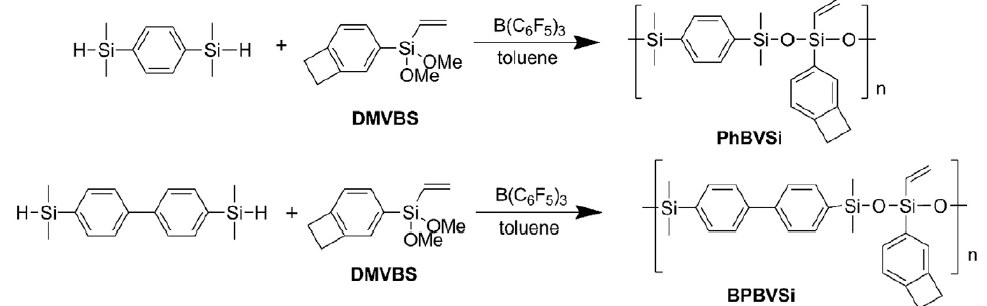
Figure 4. Synthesis of benzocyclobutene (BCB) oligomers by the PR reaction [26]. Reproduced with the copyright permission.